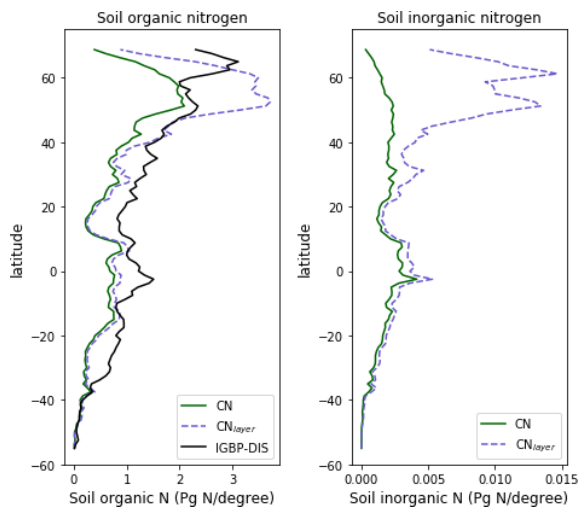
Figure 11. The zonal total soil organic and inorganic nitrogen stocks in PgN(degree of latitude) − 1 . JULES-CN layer shows the stocks for the top 1m of soil. The observations of nitrogen stocks are from Global Soil Data Task Group